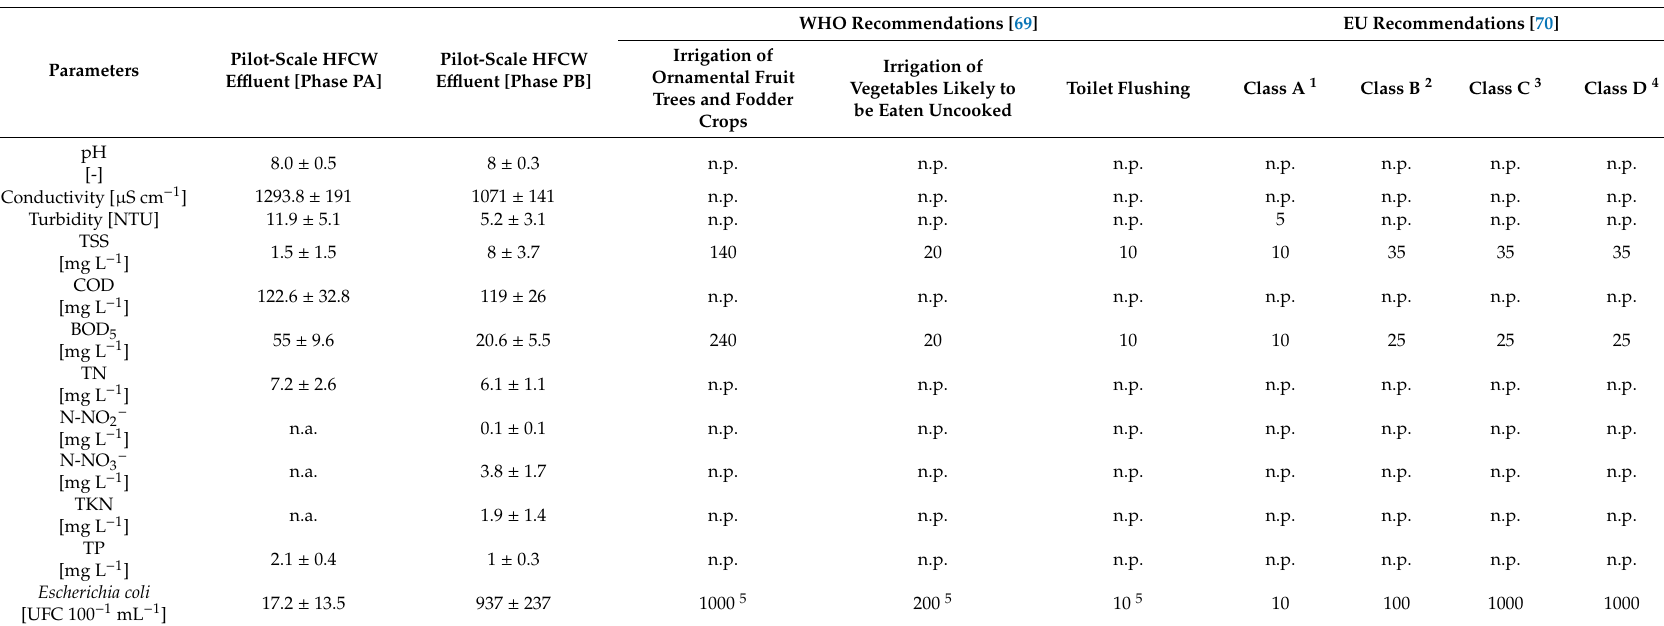
Table 3. Comparison between the characteristics of the e ffl uent and the international recommendations for the reuse of treated GW. TKN: total Kjeldahl nitrogen; n.a.: not available; n.p.: not